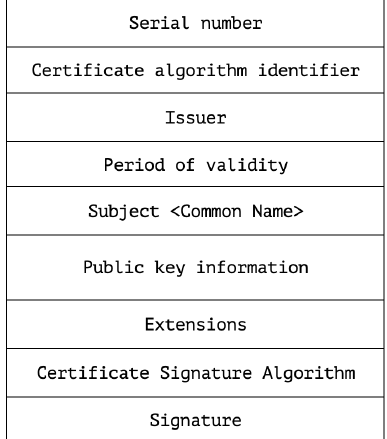
Figure 6. x.509v3 certificate